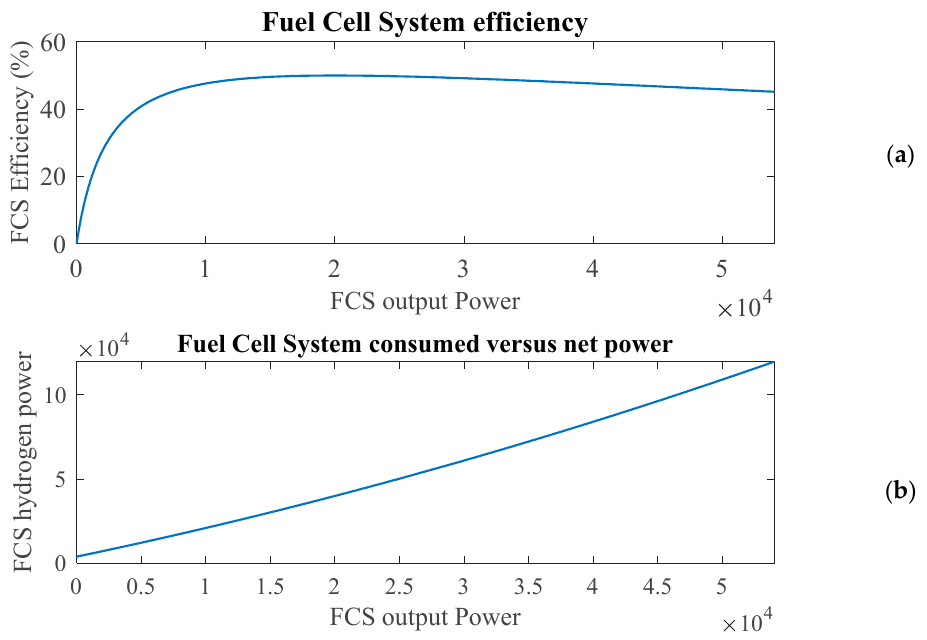
Figure 4. ( a ) Fuel cell system used efficiency; ( b ) fuel cell system used versus output power.